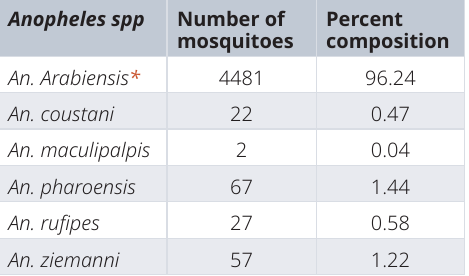
Table 1. Association between dominant graminoid plants, and the presence and abundance of Anopheles early instar larvae. Mean (95% CI) of No. Factor Anopheles early instar habitats larvae Cyperus rotundus 14 (Cyperacea)*